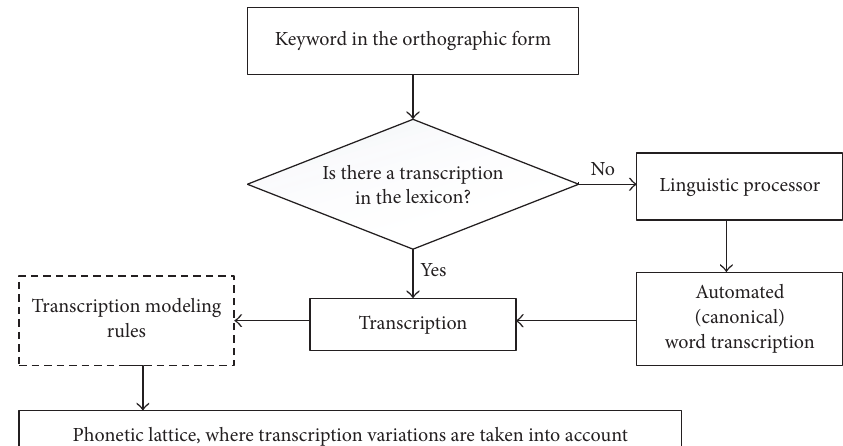
Figure 2: Transcription variation